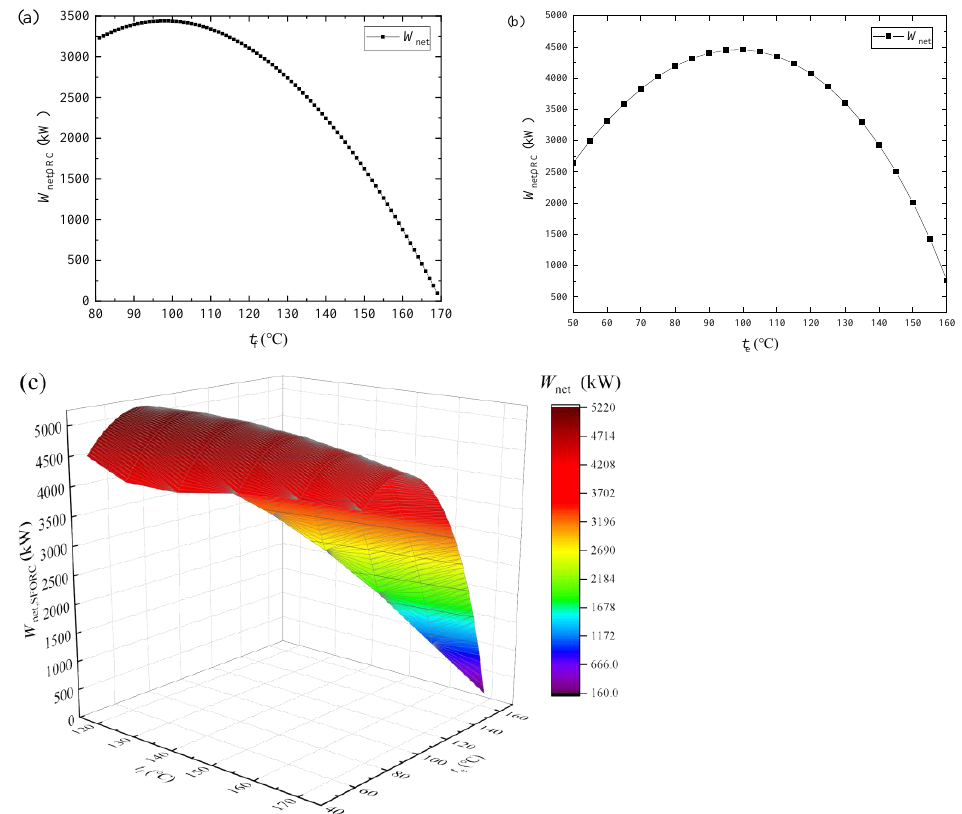
Figure 13. Variation trend of W net of three energy conversion systems: ( a ) SF system, ( b ) ORC system